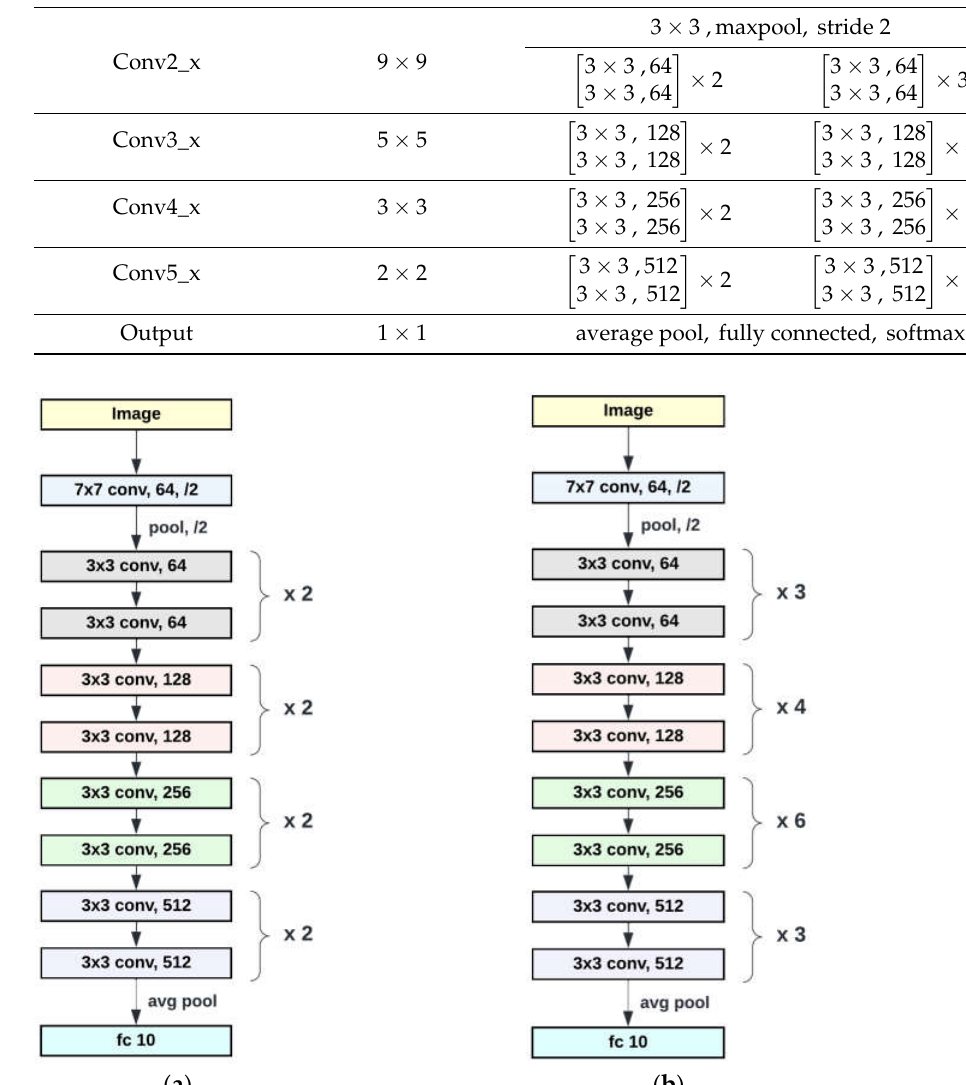
Figure 5. Block diagrams of ( a ) the 18 convolutional layer baseline; and ( b ) the 34 convolutional layer baseline models.